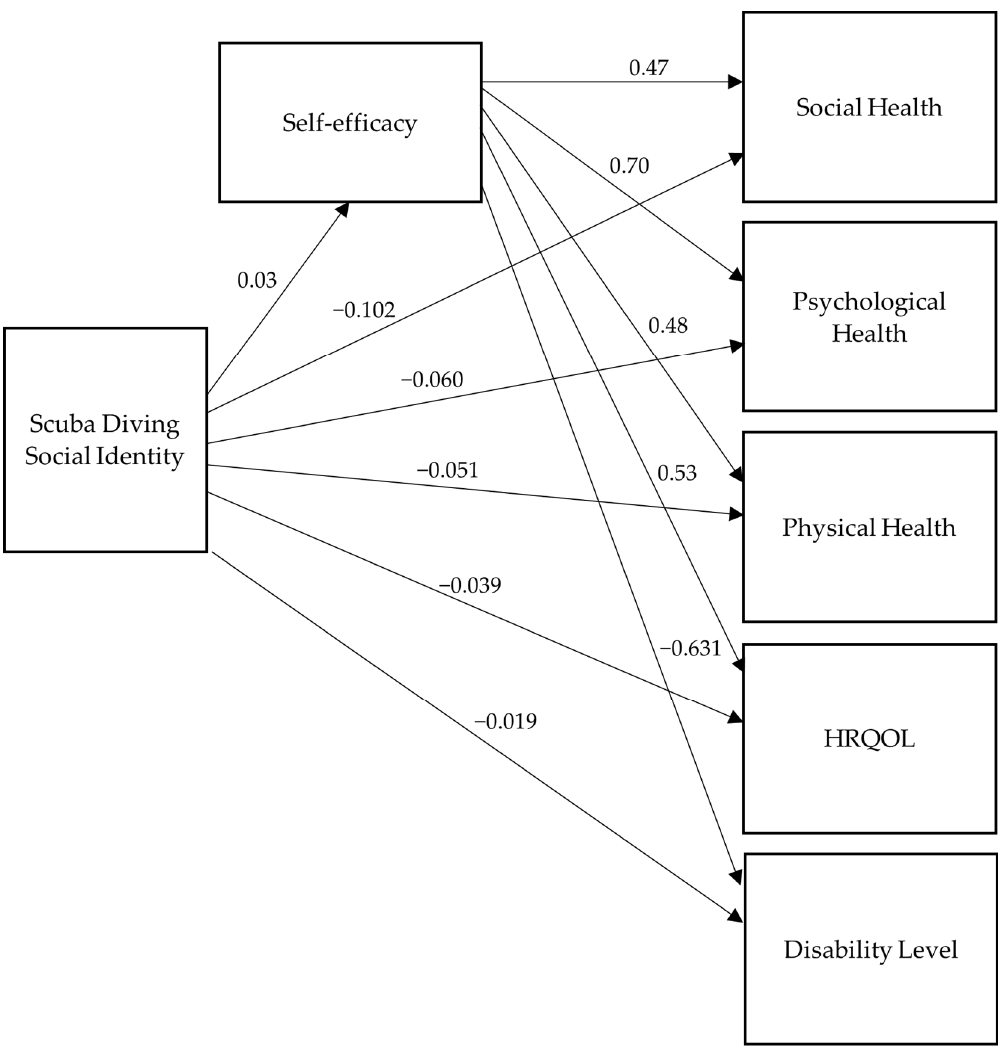
Figure 4. Standardized path model results. Table 4. Significance level of each path in the model.